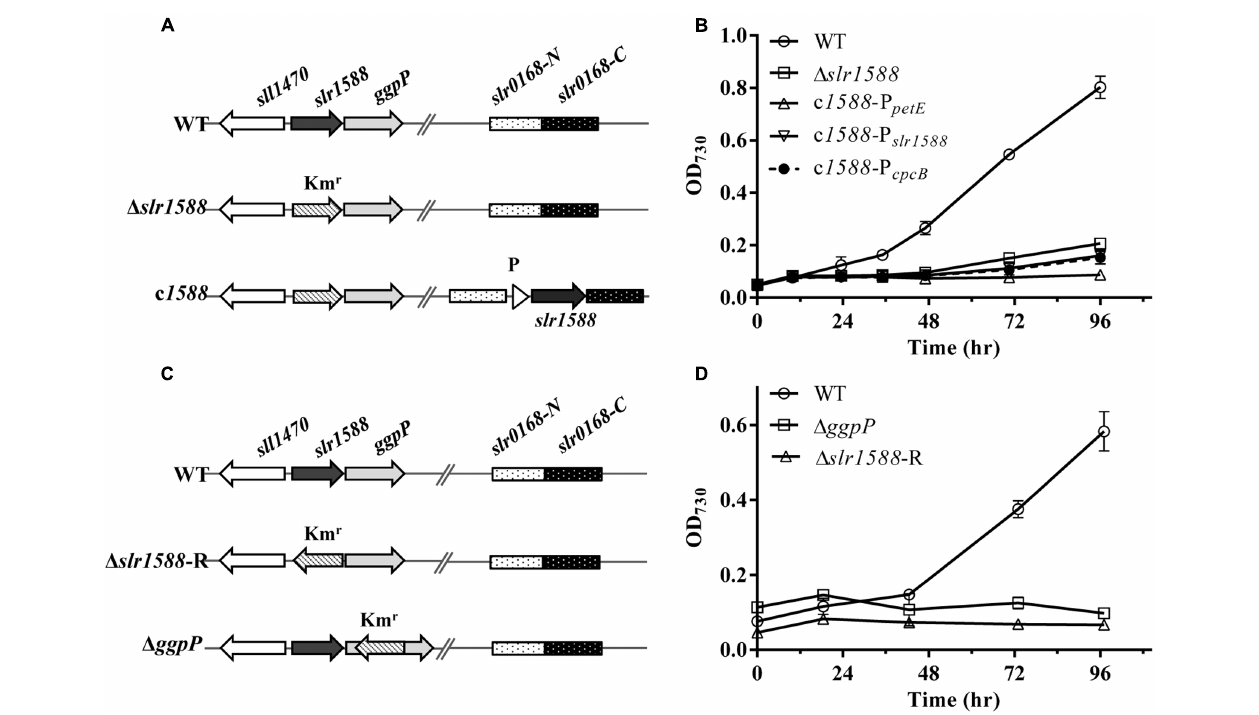
FIGURE 1 | The genomic structures and growth of different strains of Syn6803 under salt-stress condition. (A) Schematic representation of the slr1588 and the slr0168 loci in different strains. In the (cid:49) slr1588 mutant, the complete coding region of slr1588 was replaced by a kanamycin resistance cassette (Km r ). In the complementation strains, DNA fragments expressing the slr1588 gene under control of three different promoters (P: P petE , P cpcB or P slr1588 ) were inserted into the neutral slr0168 locus of the (cid:49) slr1588 mutant. (B) All five strains were grown in BG11 media containing 4% NaCl. Growth was monitored by measuring OD 730 . Error bars indicate standard deviation ( n = 3). (C) In comparison to the initial (cid:49) slr1588 mutant, the Km r fragment was inserted with reverse orientation in mutant (cid:49) slr1588 -R. The Km r fragment replaced parts of the coding sequence in the (cid:49) ggpP mutant. (D) All strains were grown in BG11 media containing 4% NaCl, and monitored by measuring OD 730 . Error bars indicate standard deviation ( n =